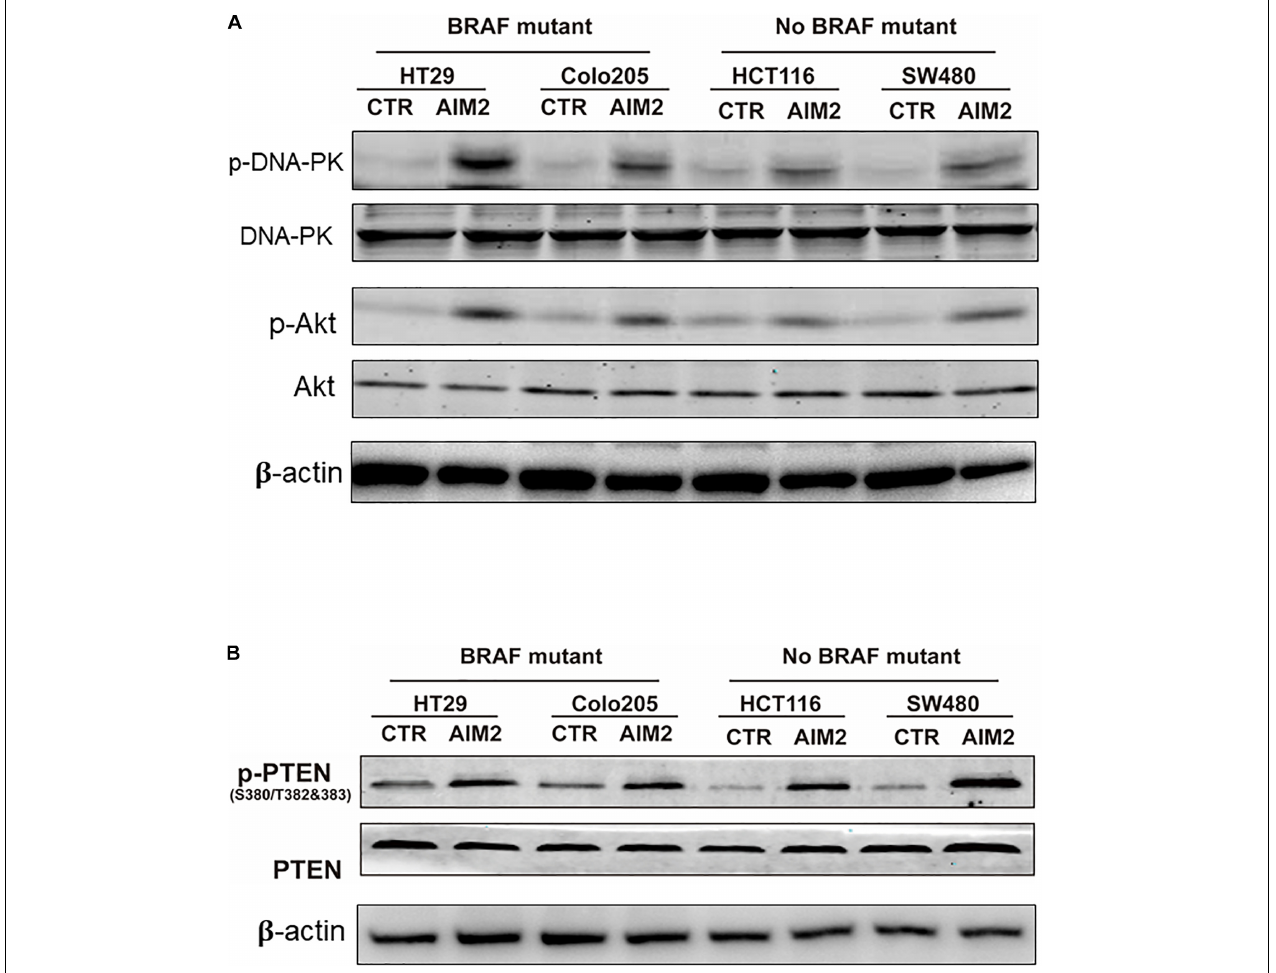
FIGURE 3 | AIM2-induced cell death is not dependent on DNA-Pk/Akt or PTEN pathway. (A) Western blot analysis of phosphorylated DNA-PK (p-DNA-PK) and p-Akt in BRAF-mutant CRC cells (HT29 and Colo205) and no BRAF-mutant cells (HCT116 and SW480) after transfection of AIM2 plasmid for 12 h. β -Actin was used as the loading control. (B) Western blot analysis of p-PTEN in BRAF-mutant cells (HT29 and Colo205) and no BRAF-mutant cells (HCT116 and SW480) at 12 h after transfection of AIM2